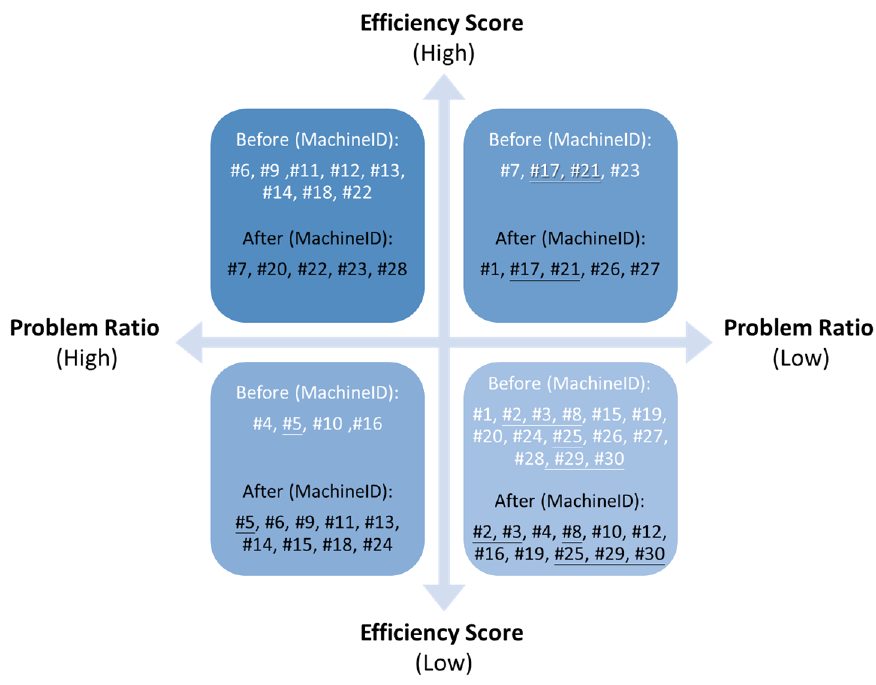
Figure 4. E ffi ciency and problem ratio matrix before and after the removal of outliers.